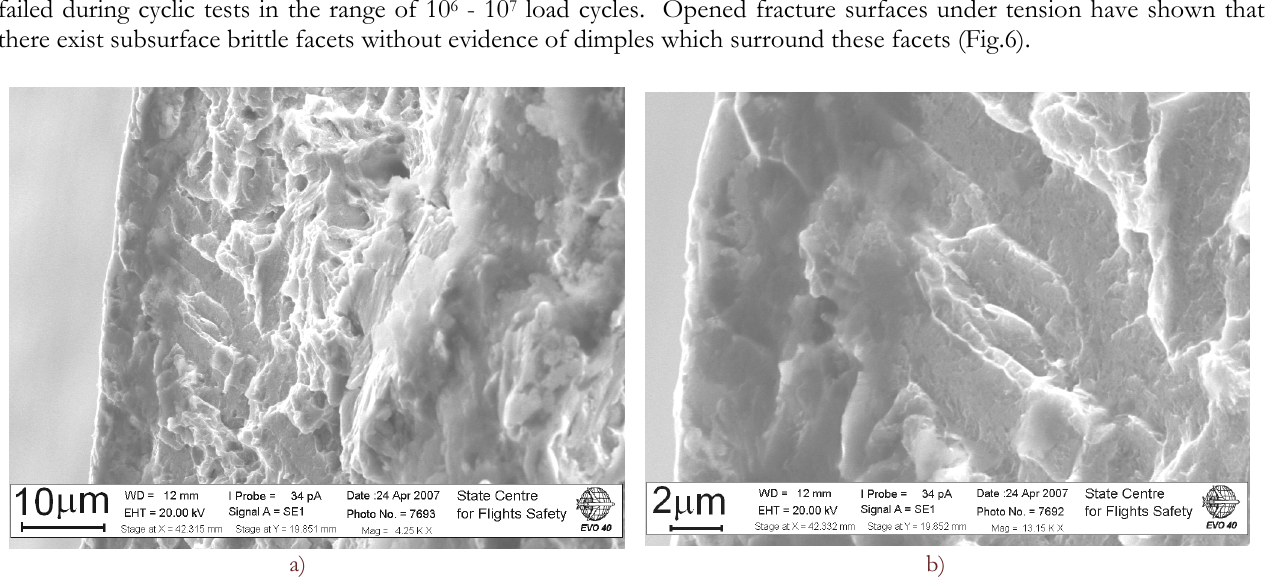
Figure 6. Fracture subsurface pattern cyclically tested T- specimen up to 10 7 cycles without failure and, then, tensed up to failure. Notched specimens have not shown the same significant clear tendency in subsurface crack origination as that found for smooth specimens. TS - specimens have shown subsurface crack origination in the range of (1.2 to 4.2)x10 6 load cycles. They were tested under negative R-ratio. That is why there are two factors, number of load cycles and negative